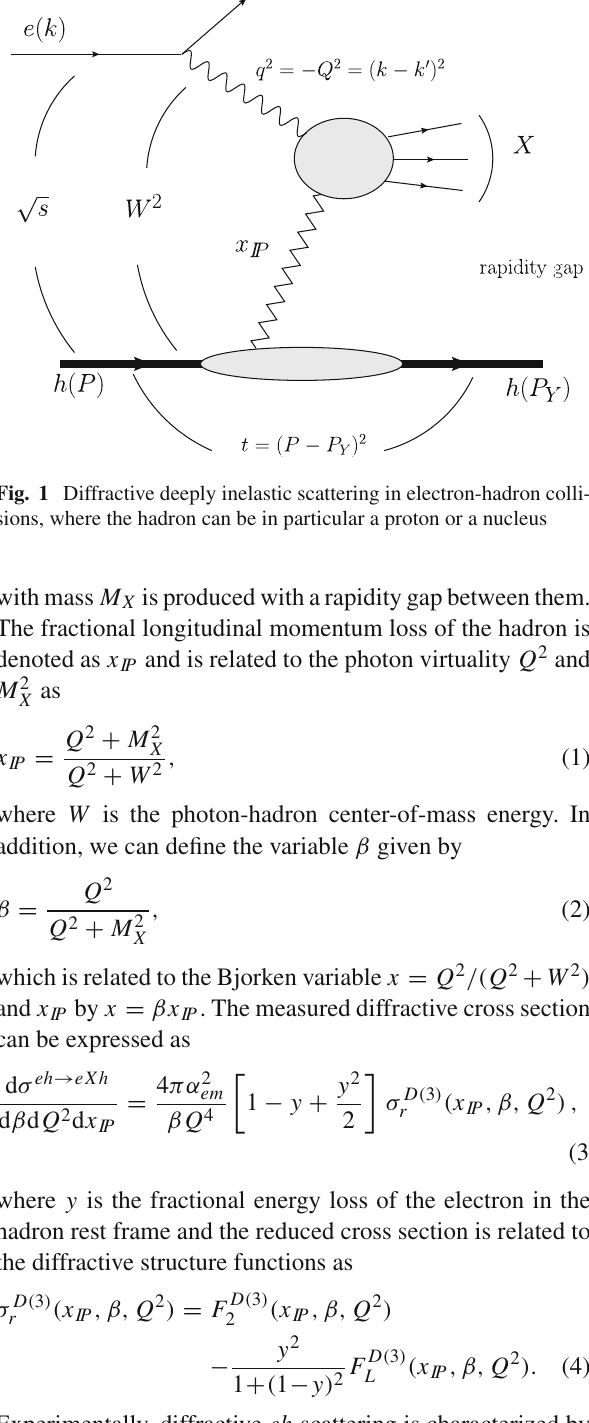
with mass M X is produced with a rapidity gap between